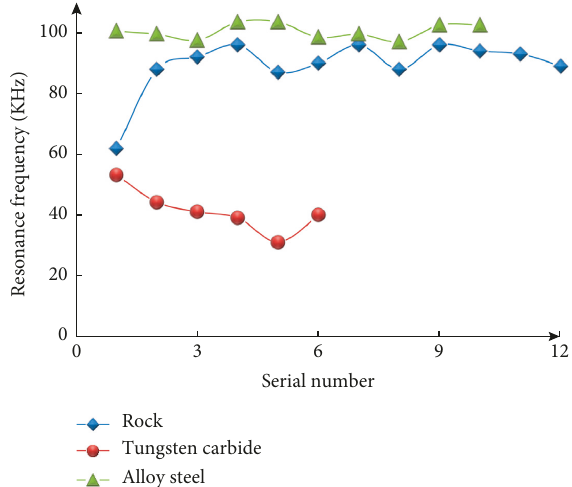
Figure 15: Comparison curves of resonance frequencies for rock and drilling